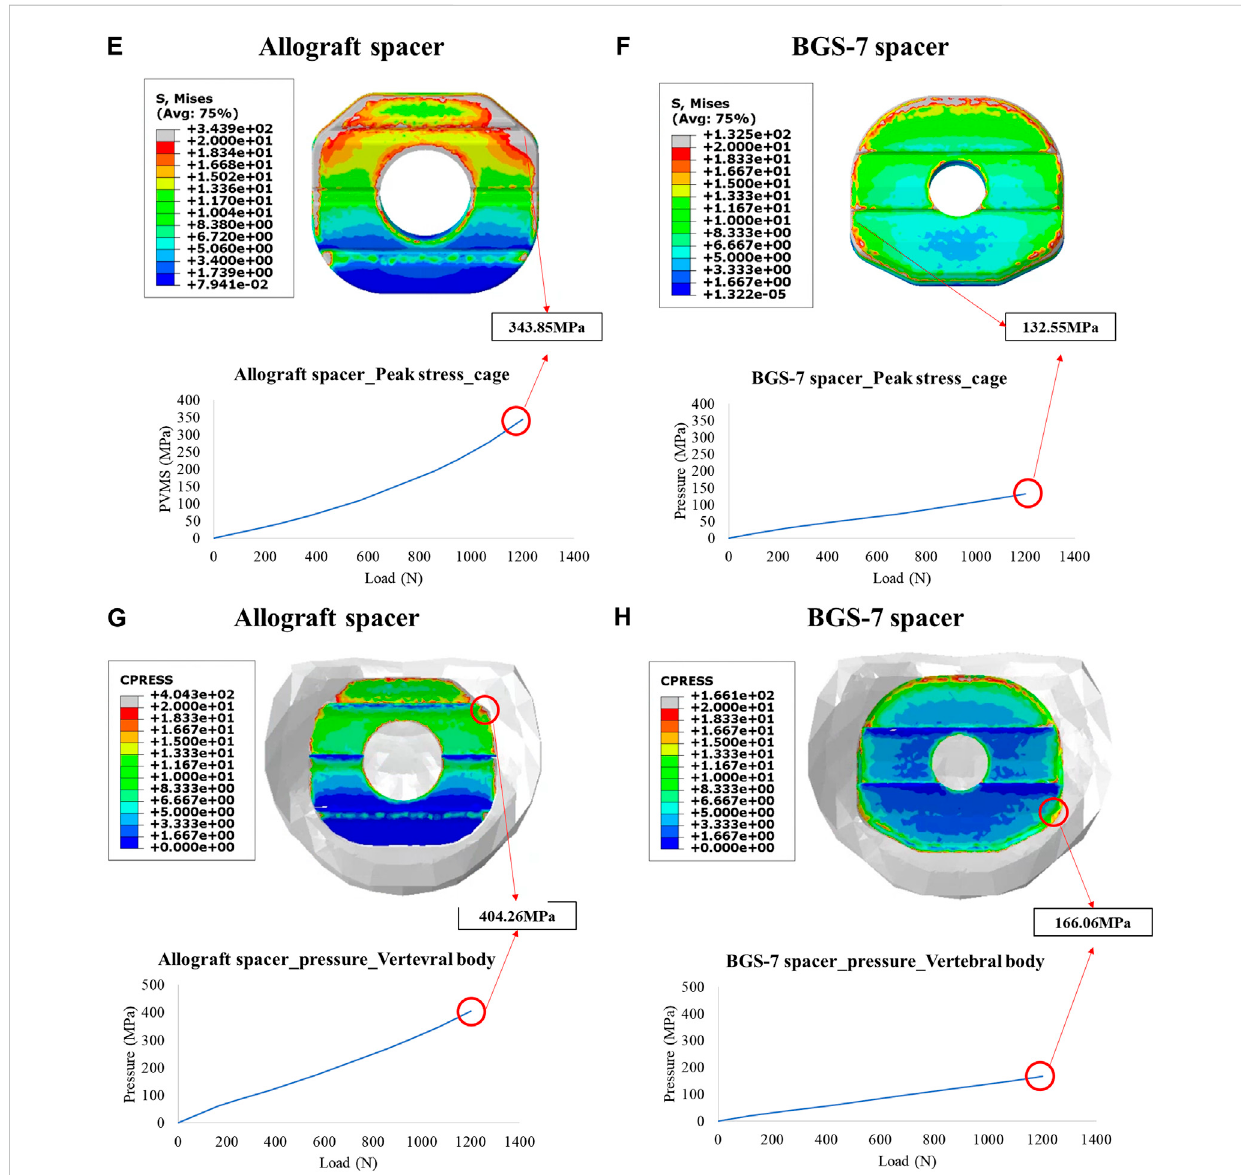
FIGURE 5 Illustrationfortwo fi niteelement models for theACDF with allograft spacer (A) , andBGS-7 spacer (B) . Peak stresson vertebralbody under 1200N of compressiveload for theallograft spacer (C) ,and BGS-7 spacer (D) .Peak stressonthecageunder1200N ofcompressive loadfor theallograft spacer (E) , and BGS-7 spacer (F) . Contact pressure under 1200N of compressive load for the allograft spacer (G) , and BGS-7 spacer (H)